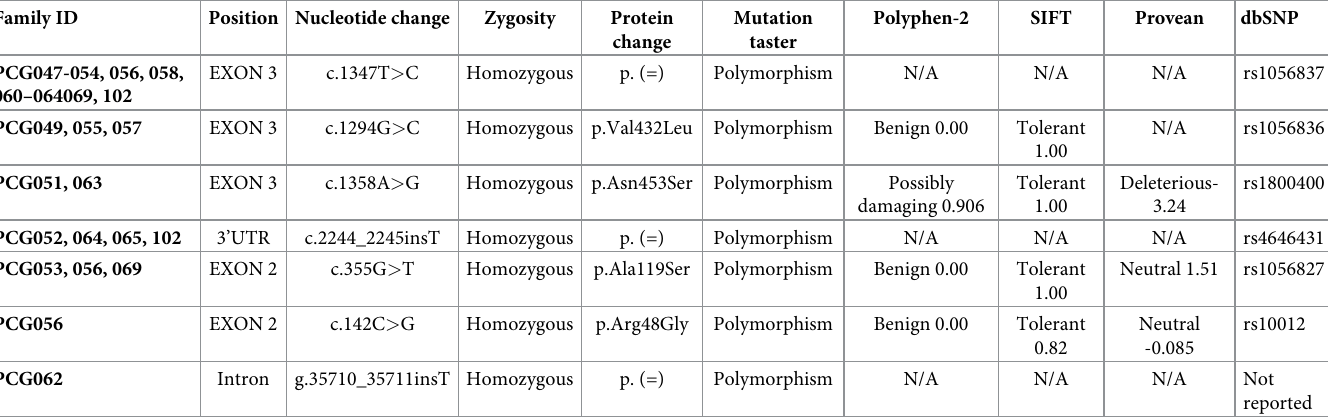
Table 2. List of reported and a previously unreported single nucleotide polymorphism detected in CYP1B1 gene in PCG patients analyzed in this study. Family